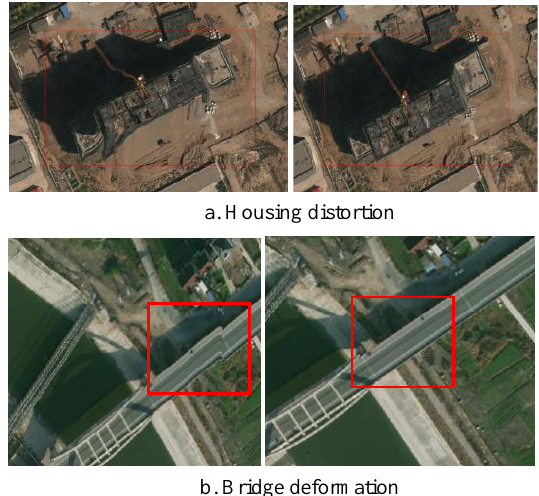
Figure 3. Effect of DOM and DEM Synchronized Editing